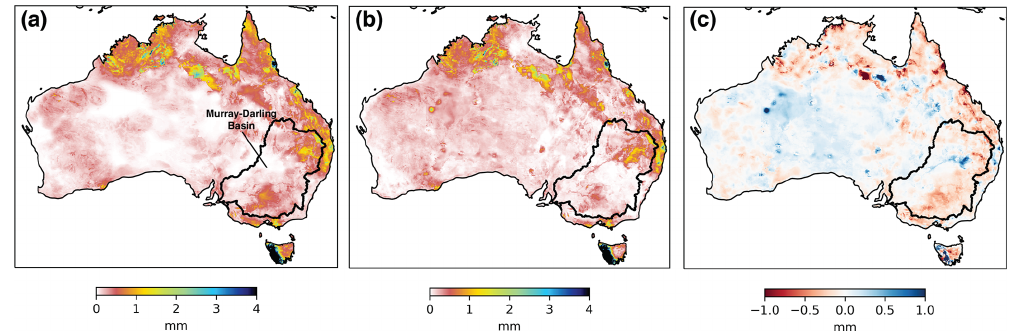
Figure 4. Comparison of average daily surface soil water storage estimates ( S 0 ) for December 2019 from (a) model open loop (OL), (b) joint assimilation of SMAP and SMOS with triple collocation (DA-TC) and (c) average change between daily estimates from DA-TC and OL.